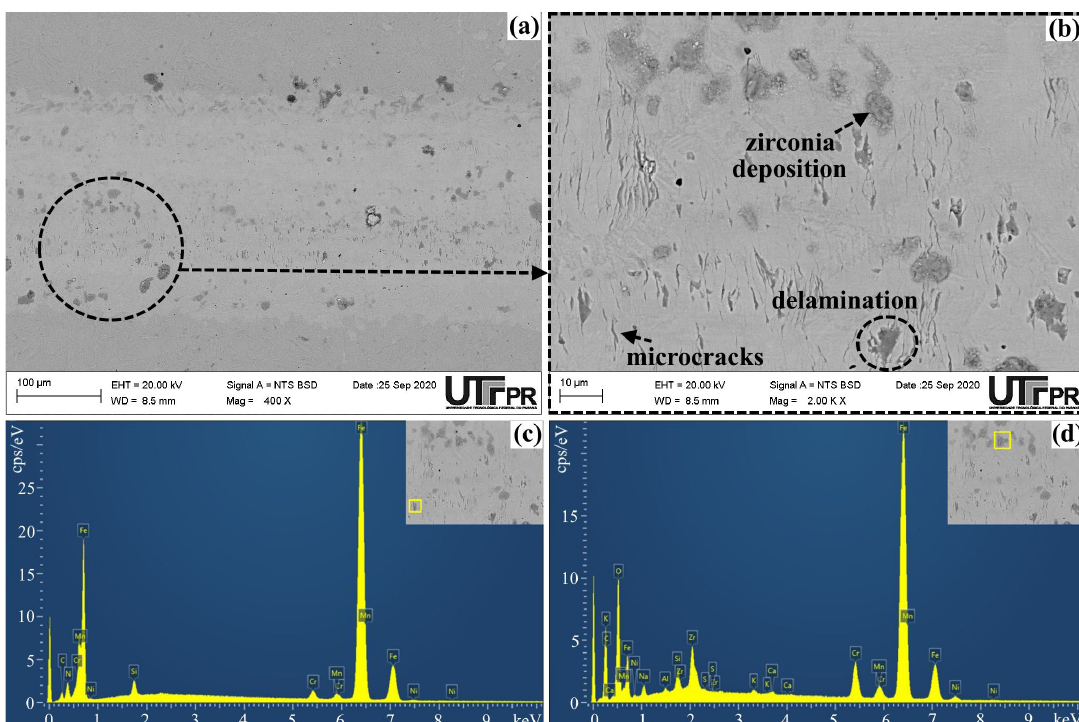
Figure 10. (a, b) SEM images and (c, d) EDS analysis of the wear tracks after reciprocal sliding wear of plasma nitrided samples for 9 h with gas mixture composition of 24 vol.% N 2